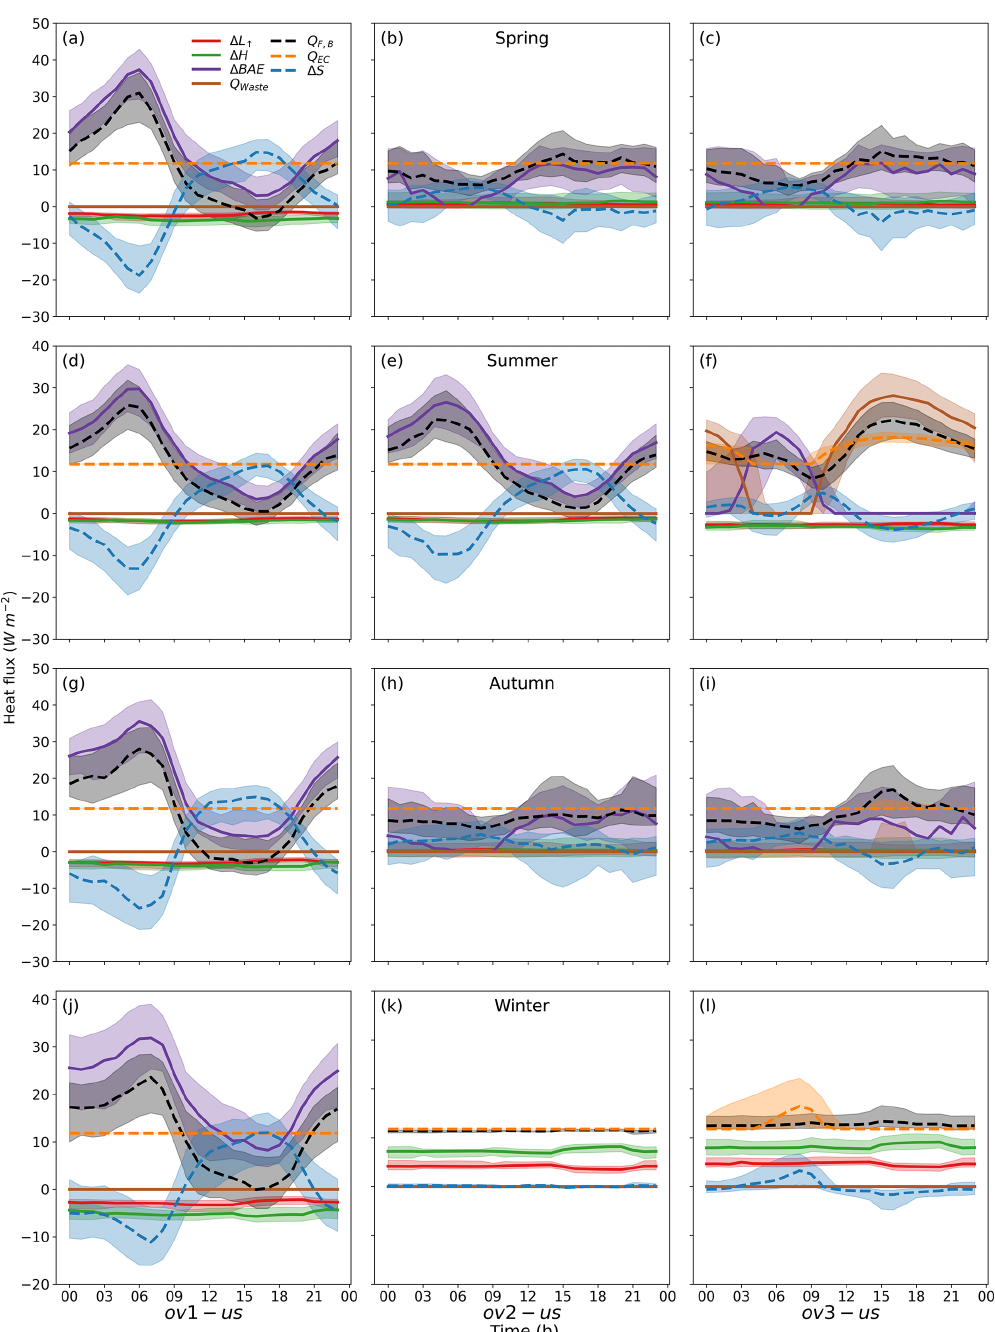
Figure 2. As Fig. 1c, f, i, j , but comparing three different building operation types (a, d, g, j) ov 1 : window is always open without control, no HVAC; (b, e, h, k) ov 2 : controlled natural ventilation for indoor thermal comfort, no HVAC; (c, f, i, l) ov 3 : mixed mode ventilation.